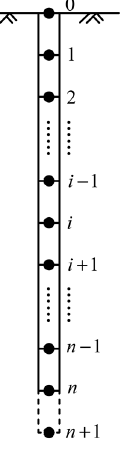
Figure 4. Schematic diagram of differential dispersion of single pile under vertical load after water immersion.